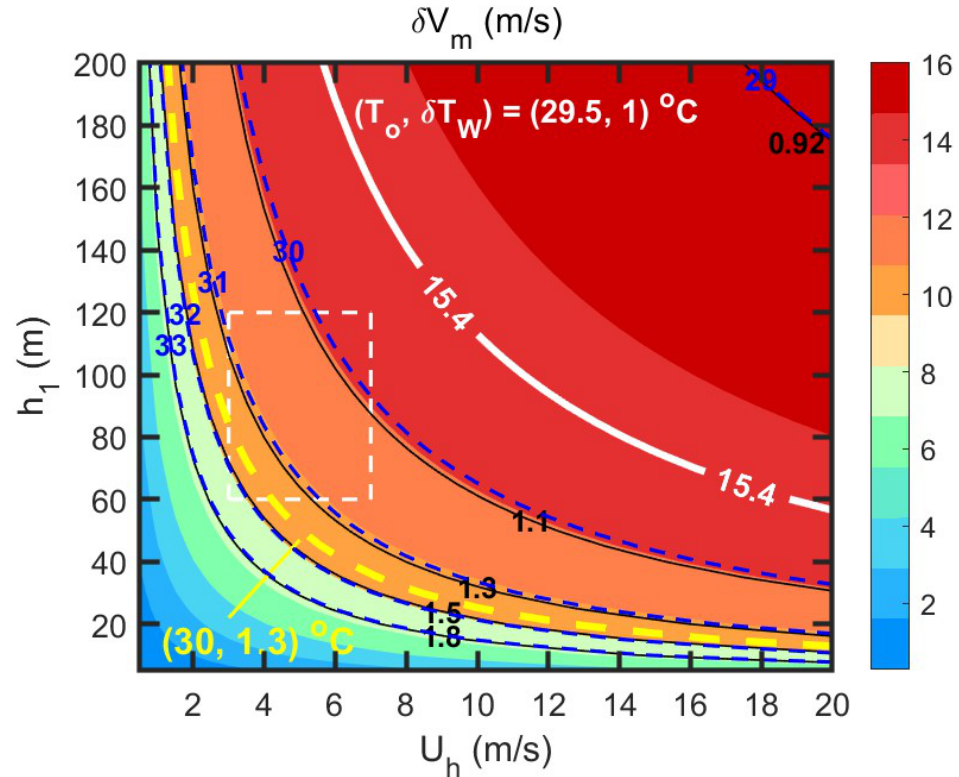
Figure 6. Western North Pacific’s δV m as a function of U h and h 1 for (T o , δT W ) = (29.5, 1) o C (shading and white 15.4 m/s‐line). Other lines are 15.4 m/s for blue dashed: T o = 29, 30, 31, 32, 33 o C at fixed δT W = 1 o C; black: δT W = 0.92, 1.1, 1.3, 1.5, 1.8 o C at fixed T o = 29.5 o C; yellow: (T o , δT W ) = (30, 1.3) o C. The white dashed box shows the 3 ≤ U h ≤ 7 m/s and 60 ≤ h 1 ≤ 120 m region where RI events are frequently observed. The model uses γ = 0.02 and V O = 30 m/s. Add 3 o C to T o to apply the plot to the Atlantic hurricanes, i.e., 29.5 o C becomes 32.5 o C, 30 o C becomes 33 o C, etc.